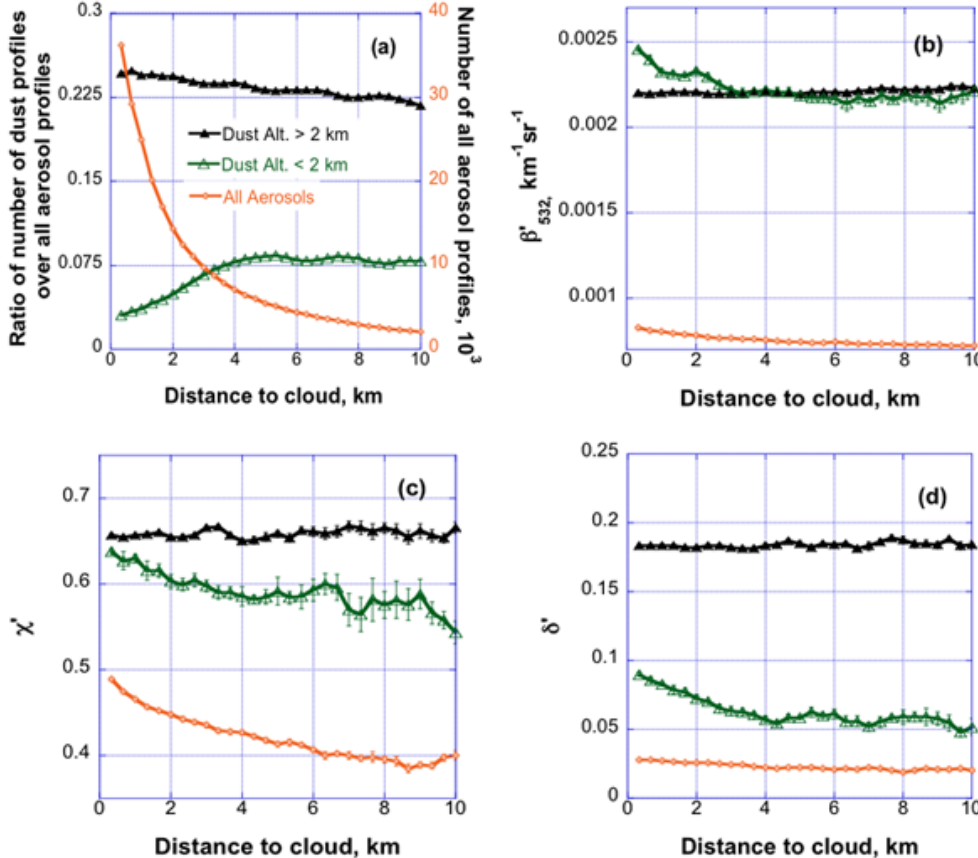
Fig. 7. Properties of high and low dust as a function of distance to clouds, combined for the three regions (W + M + E): (a) fraction of detected aerosol profiles that contain dust, (b) attenuated backscatter coefficient at 532nm, β 0 , (c) attenuated color ratio, χ 0 , (d) depolarization ratio, 532 δ 0 . The orange curve in (a) is the number of detected “all aerosol” profiles as a function of distance to clouds. It is also used as denominator in calculating the fraction of high and low dust profiles. Orange curves in (b–d) show the optical properties of all aerosols